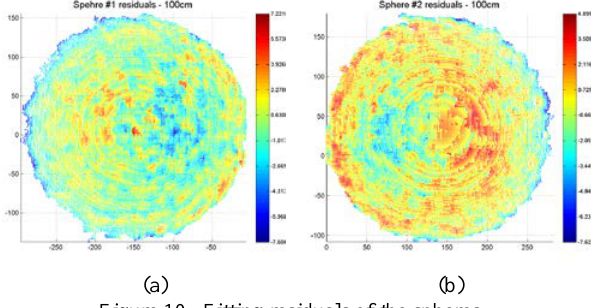
Figure 10. Fitting residuals of the spheres.